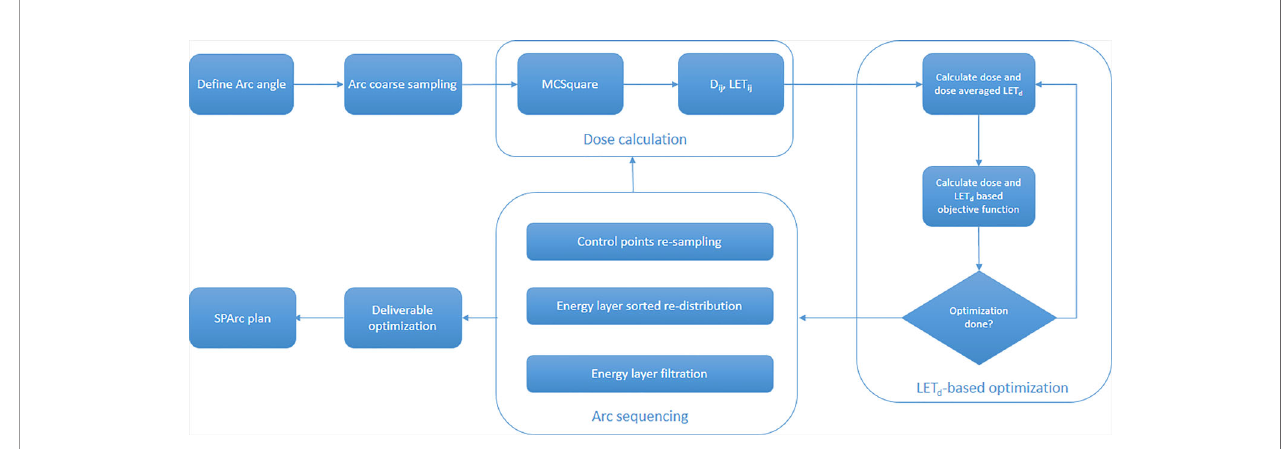
Figure 1 The work fl ow of LET d based SPArc